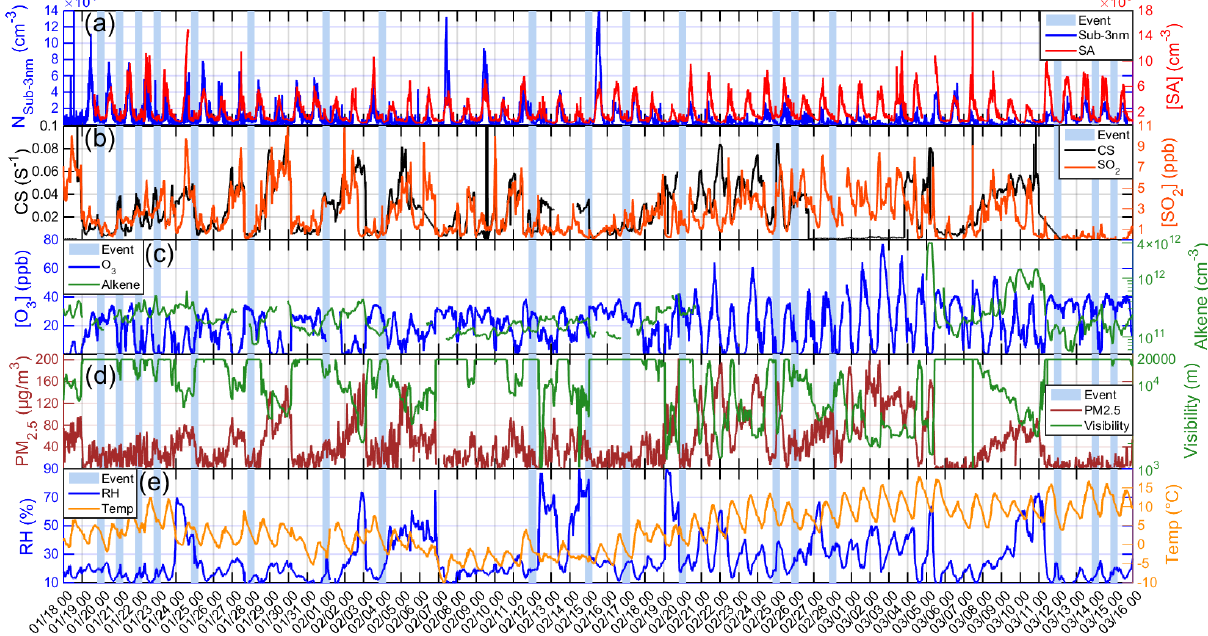
Figure 1. Overview of different parameters measured from 18 January to 15 March 2019 for (a) SA concentration and particle number concentration of sub-3nm particles ( N sub-3nm , measured by PSM), (b) CS and SO 2 concentration, (c) concentration of O 3 and alkenes, (d) PM 2 . 5 and visibility, and (e) relative humidity (RH) and temperature. The light blue bars represent nights with nighttime SA events.